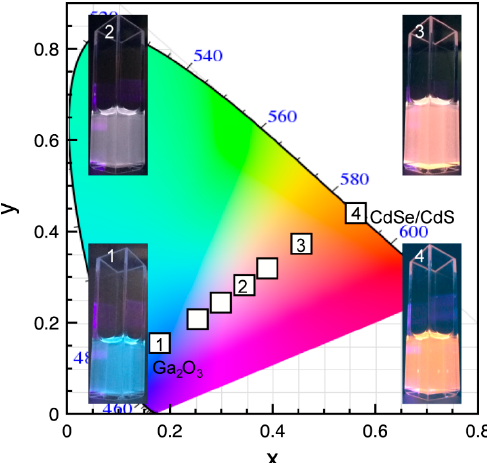
Figure 7. International Commission on Illumination 1931 (CIE 1931) color coordinate diagram for Ga 2 O 3 -CdSe/CdS NC conjugate having different acceptor to donor ratio. The photographs of the colloidal nanoconjugates corresponding to data points labeled in the graph are shown as insets.